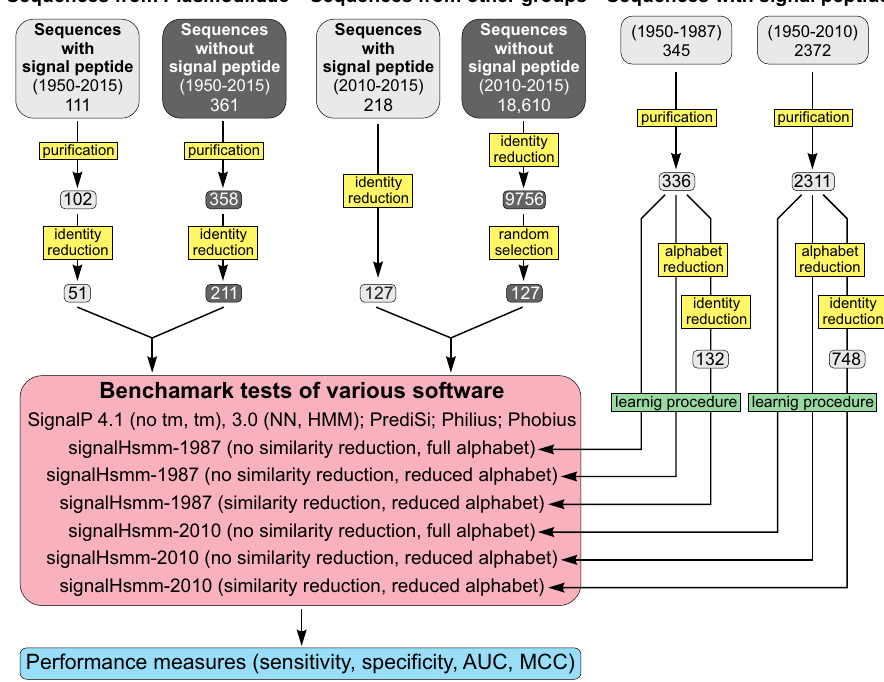
Figure 5. Data selection, training, testing and evaluation of signalHsmm.